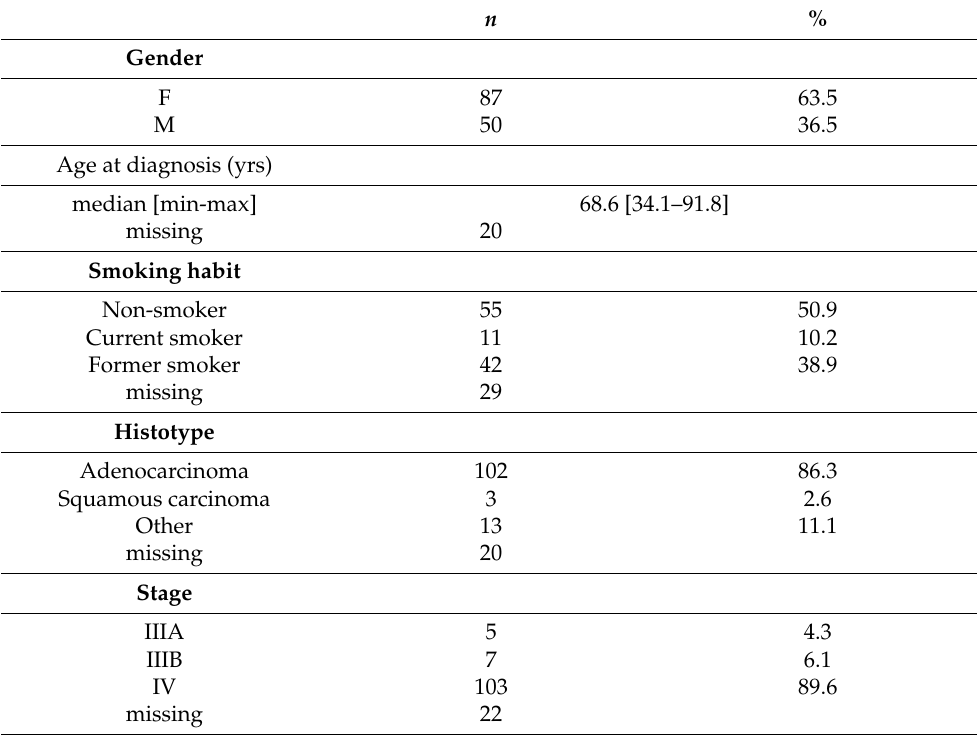
Table 1. Clinico-pathological patient characteristics ( n =